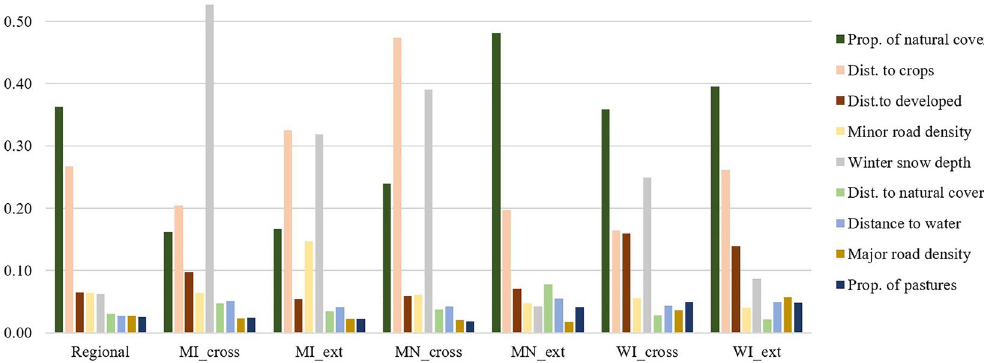
Figure 4. Average variable permutation importance (8 models, see “Methods”) for wolf distribution models, western Great Lakes region, USA, 2017–2020. Shown are the regional model and each single-state cross- validation and extrapolation model (see Fig. 2). MI Michigan, MN Minnesota, WI Wisconsin, ‘ cross ’ cross- validation, and ‘ ext ’